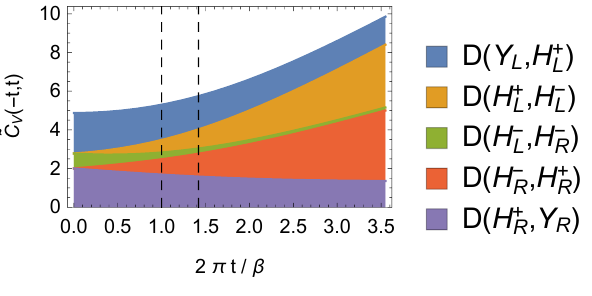
Figure 6 . The complexity growth of a heavy Heisenberg operator. The parameters are Q = 100 , L = 30 , µ = 20 and θ = π/ 20